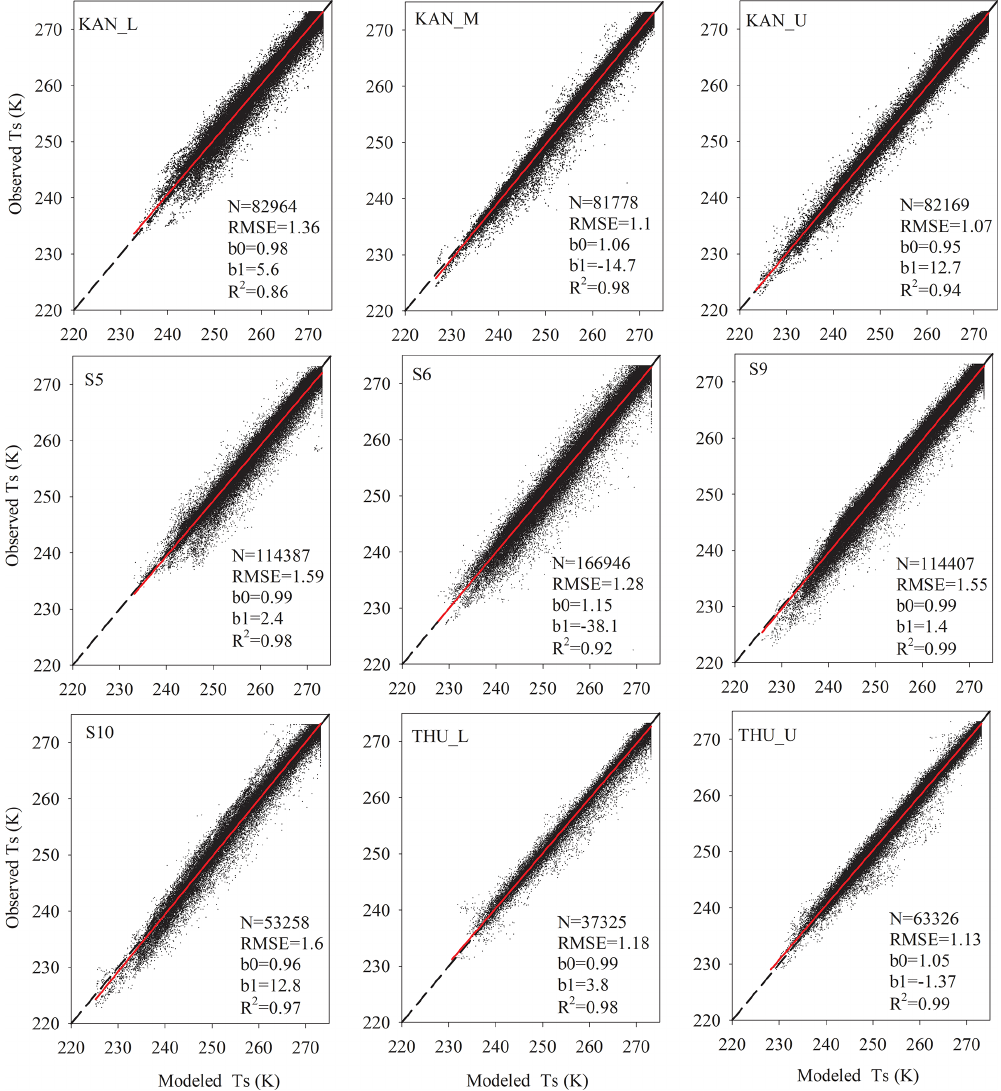
Figure 4. Modeled and observed hourly surface temperature T s for the nine AWSs. The dashed black line represents the 1 : 1 line and the solid red line the linear regression. Statistics show the number of data points ( N ), root mean squared error (RMSE), regression slope ( b 0 ) and intercept ( b 1 ), and coefficient of determination ( R 2